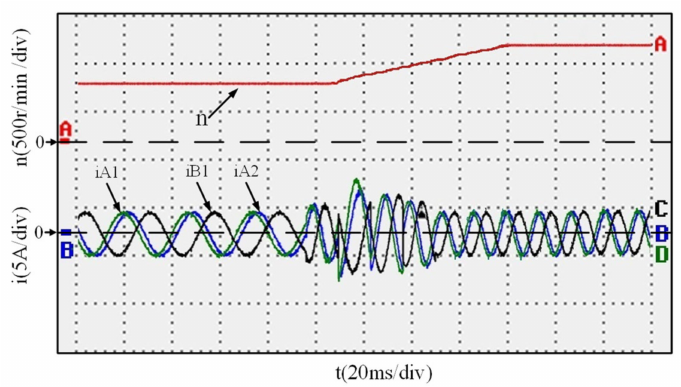
Figure 27. The waveforms when the speed changed.